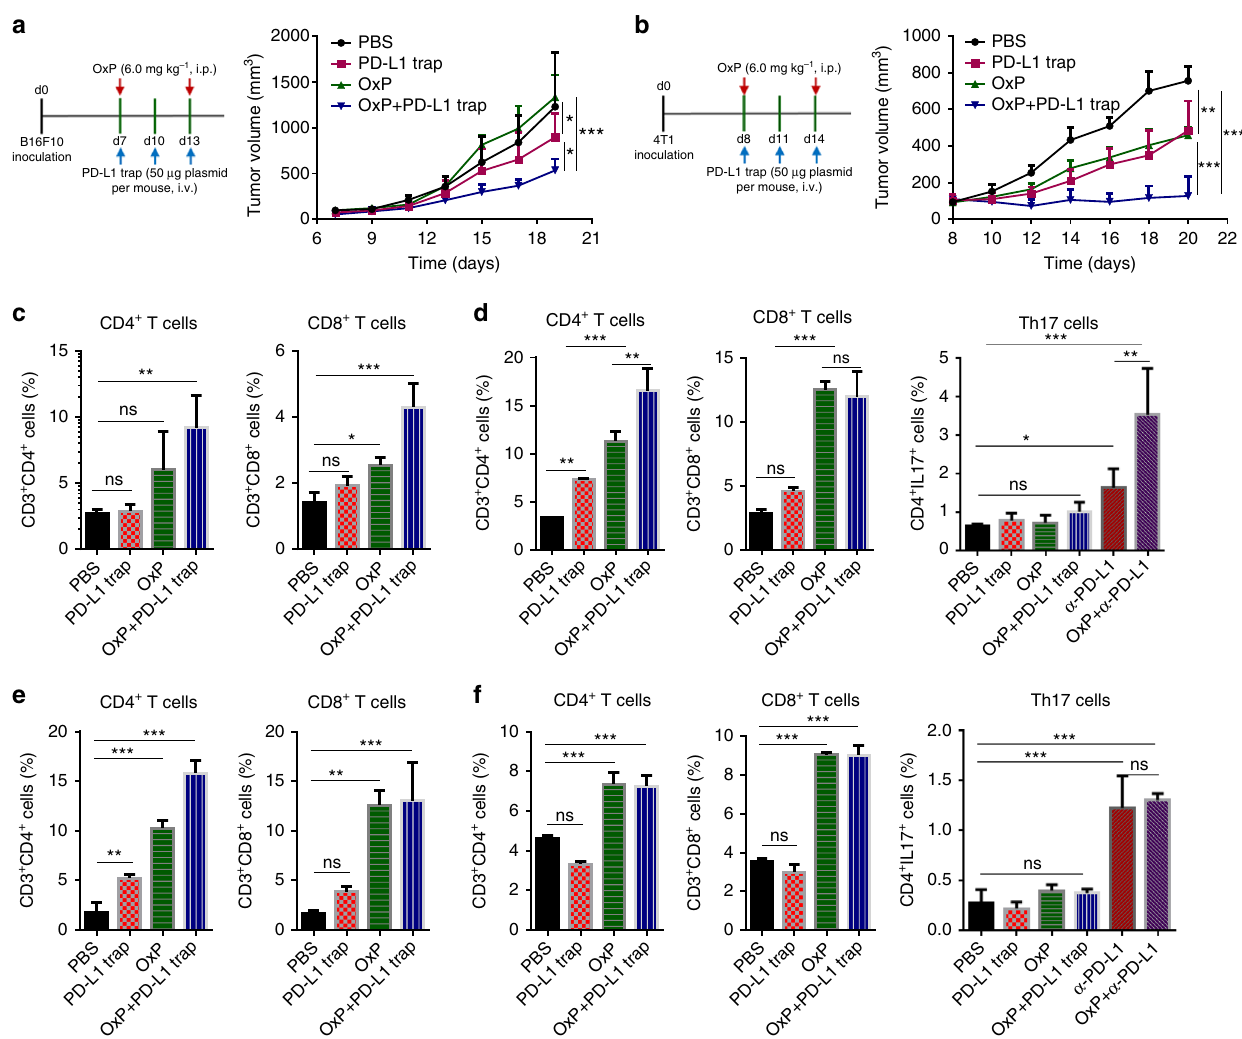
Fig. 6 OxP and LPD-PD-L1 trap gene therapy on B16F10 and 4T1 tumor models. a Treatment scheme and tumor growth curves of B16F10 tumors in PBS, PD-L1 trap, OxP and OxP + PD-L1 trap treated groups ( n = 5 mice per group). b Treatment scheme and tumor growth curves of 4T1 tumors in PBS, PD-L1 trap, OxP and OxP + PD-L1 trap treated groups ( n = 5 mice per group). c CD4 + and CD8 + T cell ratios in the B16F10 tumors after various treatments, analyzed by fl ow cytometry ( n = 4). d CD4 + T cell, CD8 + T cell and Th17 cell ratios in splenocytes of the B16F10 tumor-bearing mice after various treatments, analyzed by fl ow cytometry ( n = 4). e CD4 + and CD8 + T cell ratios in the 4T1 tumors after various treatments, analyzed by fl ow cytometry ( n = 4). f CD4 + T cell, CD8 + T cell and Th17 cell ratios in splenocytes of the 4T1 tumor-bearing mice after various treatments, analyzed by fl ow cytometry ( n = 4). Signi fi cant differences were assessed in a and b using two-way ANOVA with multiple comparisons and in c , d , e , and f using t test. Results are presented as mean (SD). ns, not signi fi cant. * P < 0.05, ** P < 0.01, *** P <